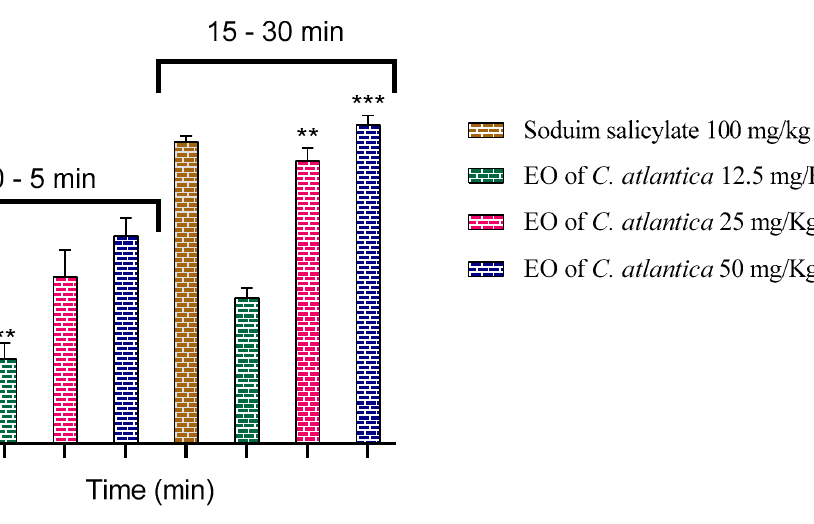
Figure 6. Percentage of pain inhibition. Values are expressed as mean ± SD ( n = 5). ** p < 0.01, *** p < 0.001 compared with positive control.